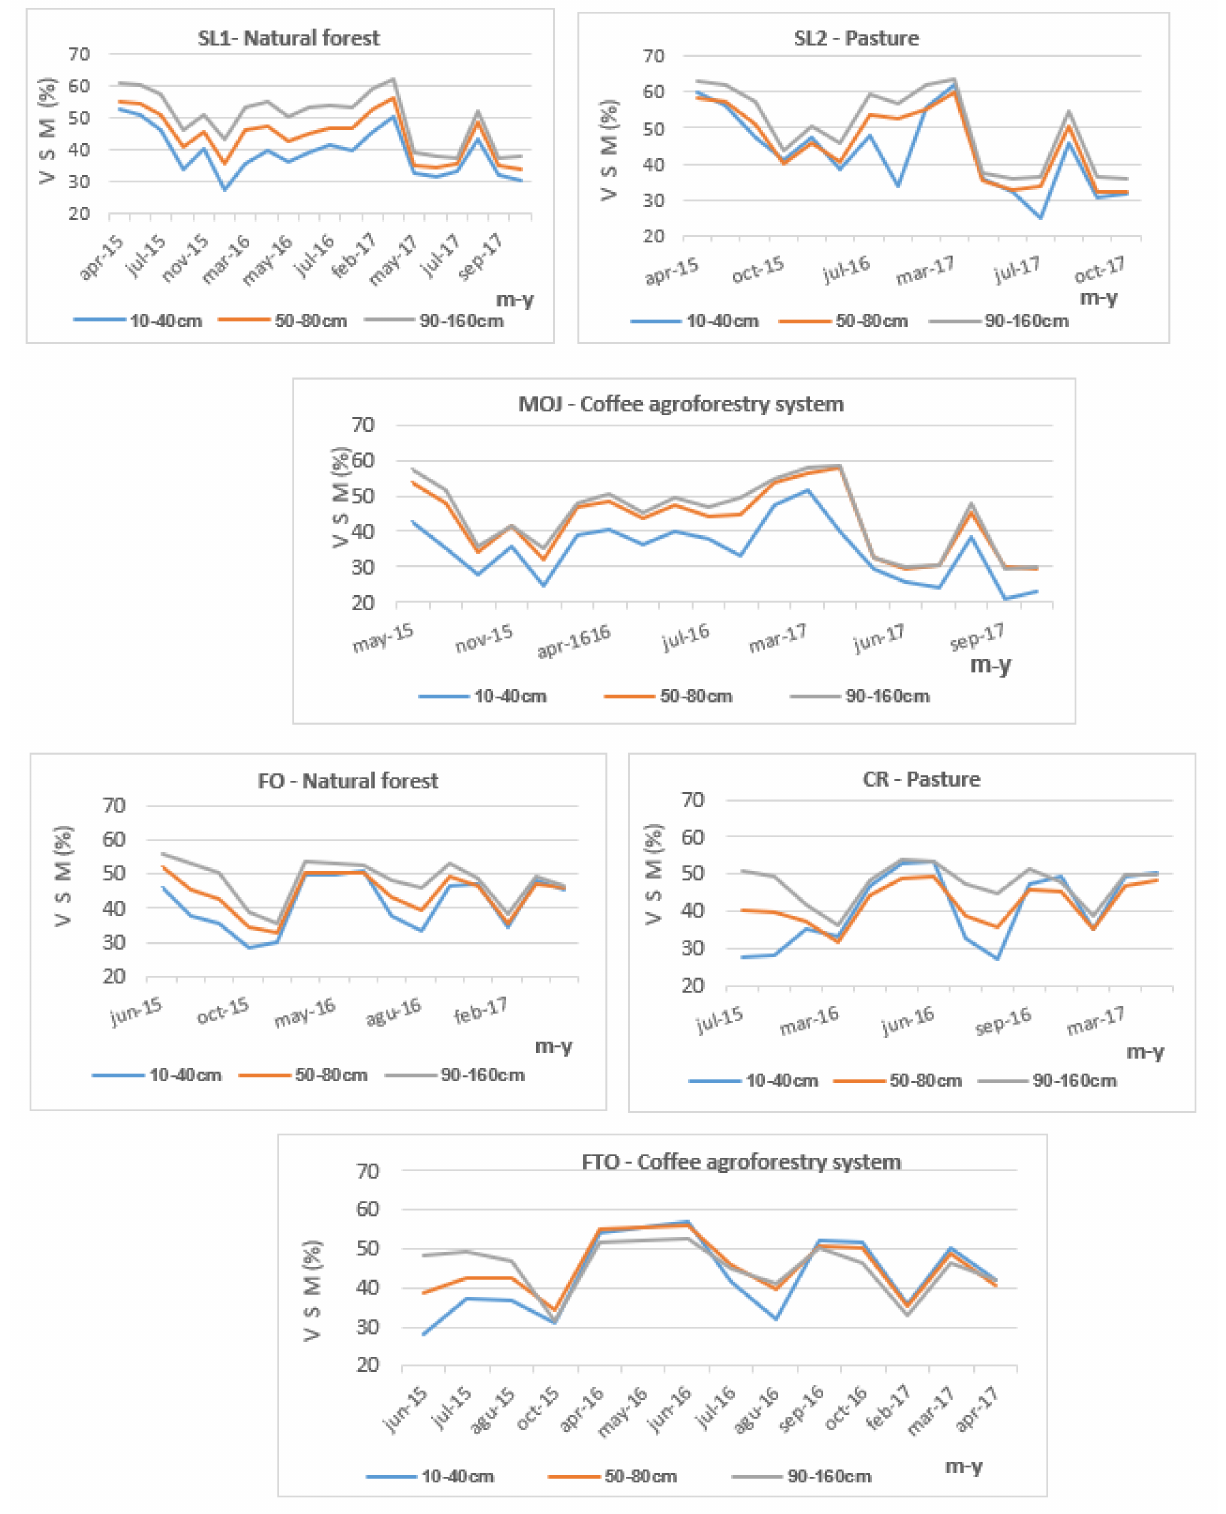
Figure 4. Behavior of the average volumetric soil moisture (VSM) for depth ranges 1 (10–40 cm), 2 (50–80 cm) and 3 (90–160 cm) at each microbasin and soil use SL1, SL2, MOJ, Combeima River basin and FO, CR, FTO, Cali River